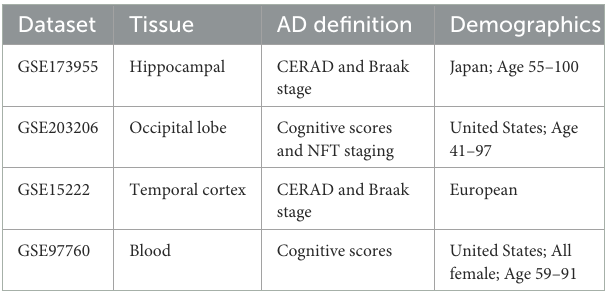
TABLE 1 The description of different